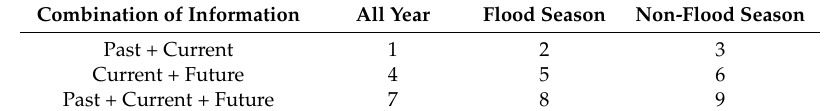
Table 2. Designed nine scenarios for building outflow simulation models.